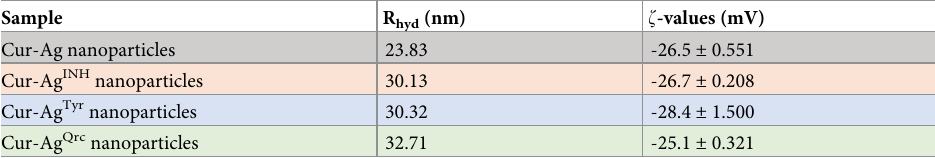
Fig 2. Physicochemical characterization of nanoparticles by UV-visible spectroscopy, TEM micrographs, nanoparticles solution images, and FTIR. Typical SPR absorbance bands of Ag nanoparticles (Panel A). Digital photographs of the nanoparticle’s solution and TEM micrographs of Cur-Ag (a), Cur- Ag INH (b), Cur-Ag Tyr (c), and Cur-Ag Qrc (d) nanoparticles, respectively. The scale bar in TEM micrographs is 50 nm (Panel B). Critical vibrational frequencies of curcumin, isonicotinic acid hydrazide, tyrosine, and quercetin on the surface of Ag nanoparticles; a, b, c, and d correspond to Cur-Ag, Cur-Ag INH , Cur- Ag Tyr , and Cur-Ag Qrc nanoparticles, respectively (Panel C). The chemical reactions of tyrosine, isoniazid, and quercetin molecules at alkaline pH at the surface of Cur-Ag nanoparticles (Panel D). https://doi.org/10.1371/journal.pone.0276296.g002 Table 1. Hydrodynamic size and z - potential values of Cur-Ag, Cur-Ag INH , Cur-Ag Tyr, and Cur-Ag Qrc